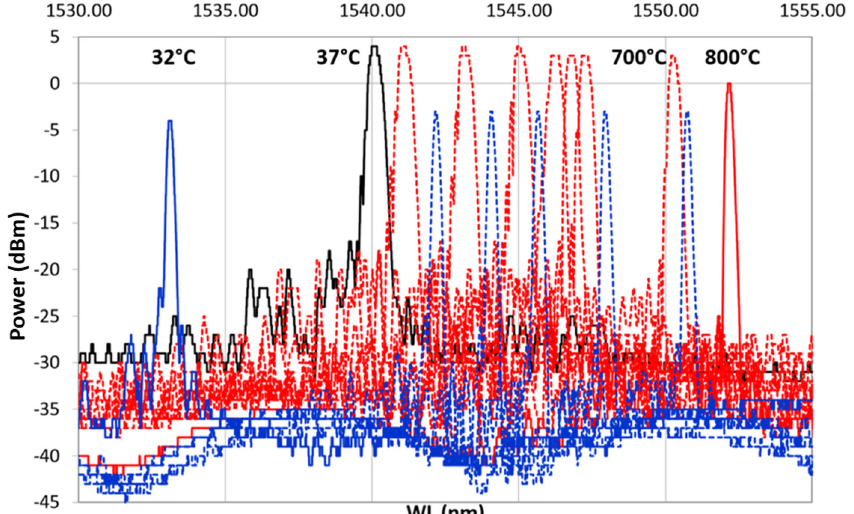
Figure 8. First heating/cooling cycle. In black is shown the spectrum at (RT) at the beginning of the cycle. The dotted red line represents the heating ramp from 37 ◦ C to 800 ◦ C, which is represented with a solid red line; the dotted blue line is the cooling ramp from 800 ◦ C to 32 ◦ C, shown using a solid blue